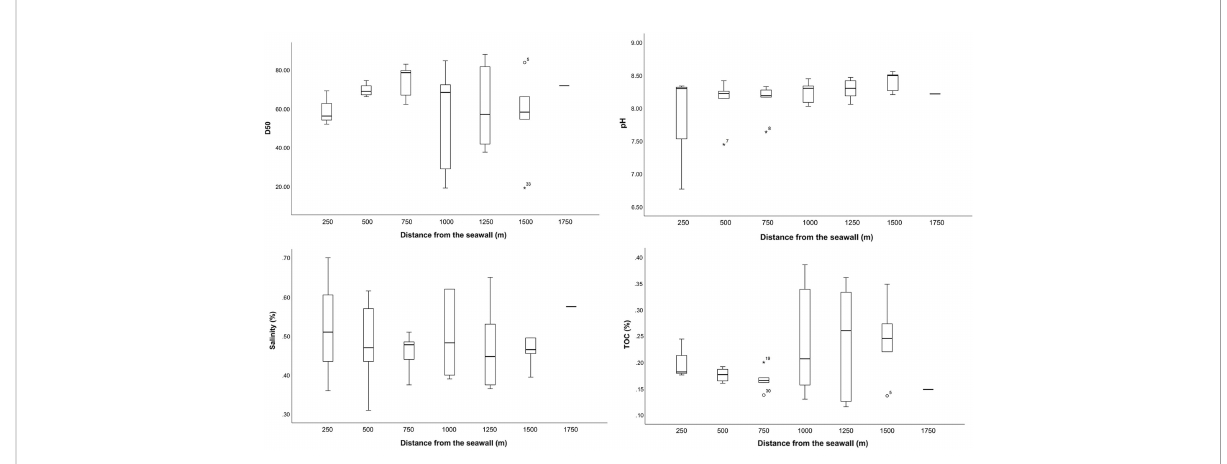
FIGURE 2 Median particle size (D50), pH, salinity, and total organic carbon (TOC) content of sediment samples. * symbol represents the extreme value in the